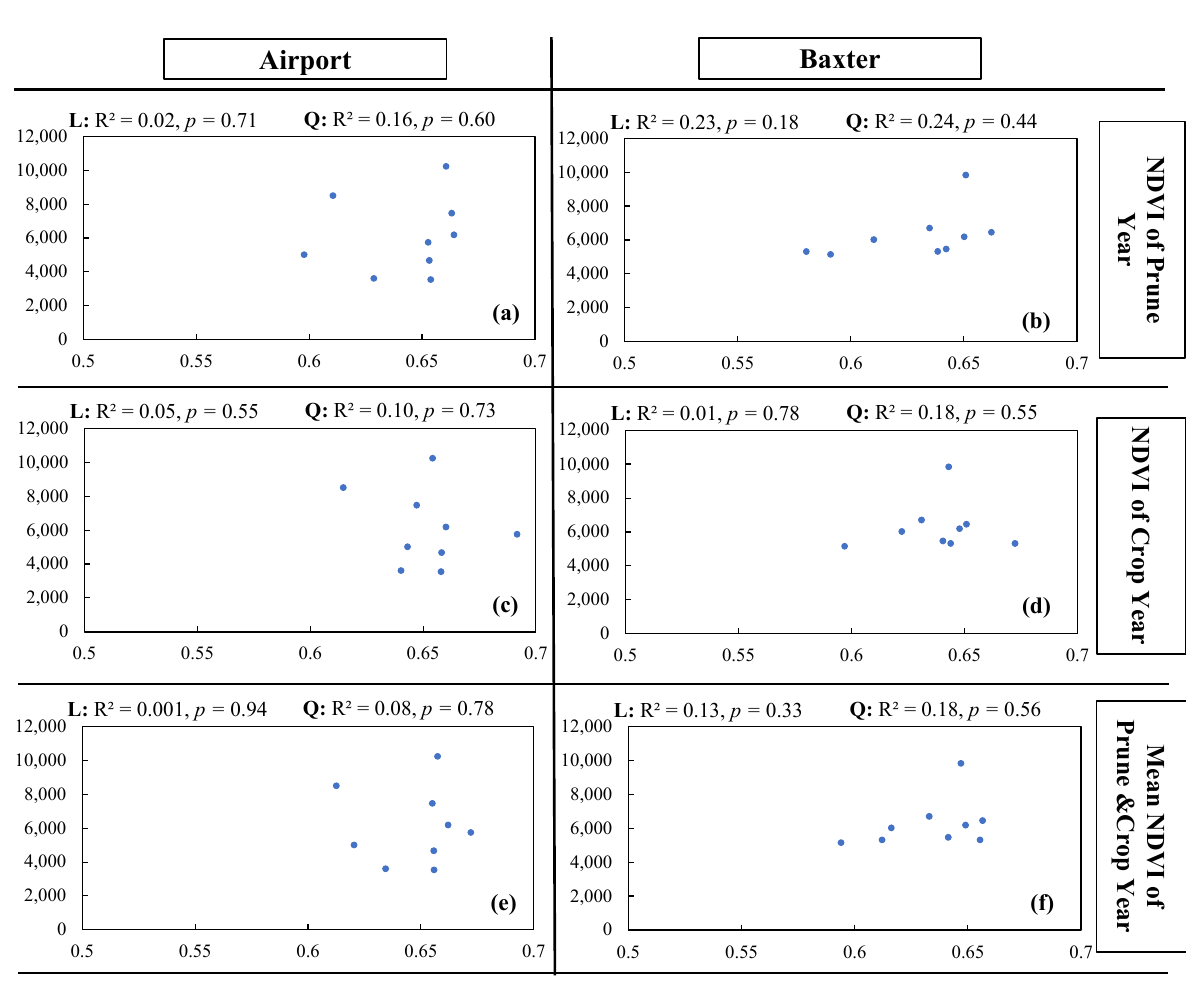
Figure 10. Relationship between wild blueberry yield (lbs./acre) and the average normalized difference vegetation index (NDVI) of ( a , b ) the prune year, ( c , d ) the crop year, and ( e , f ) the average of the prune and crop year from the Airport (irrigated) and Baxter (non-irrigated) fields in Deblois, Maine.